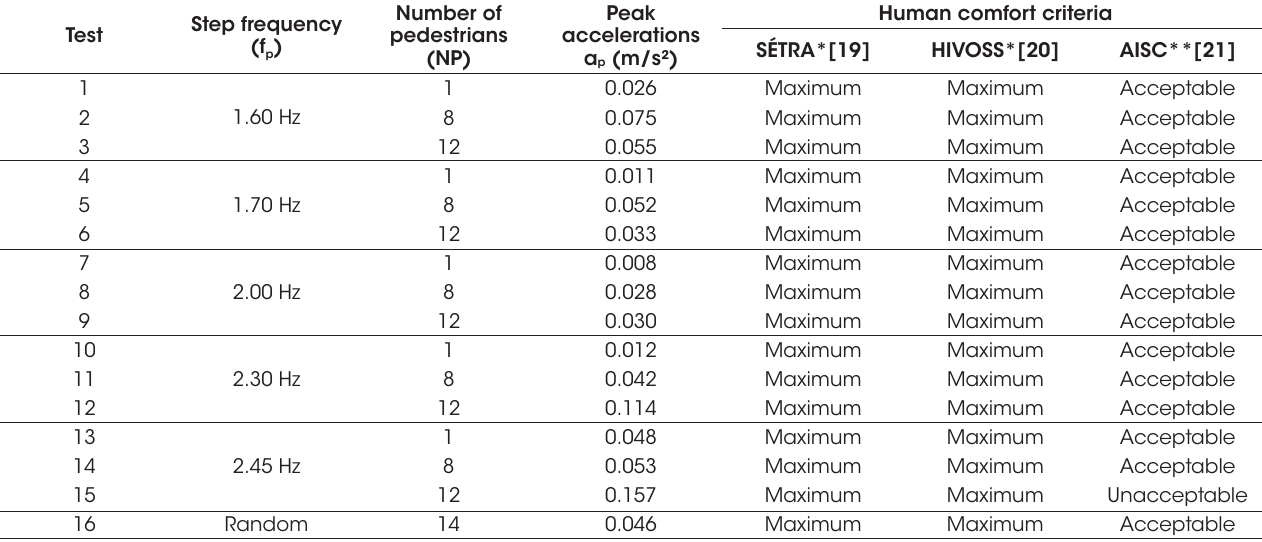
Table 4 Peak acceleration of the experimental tests and human comfort